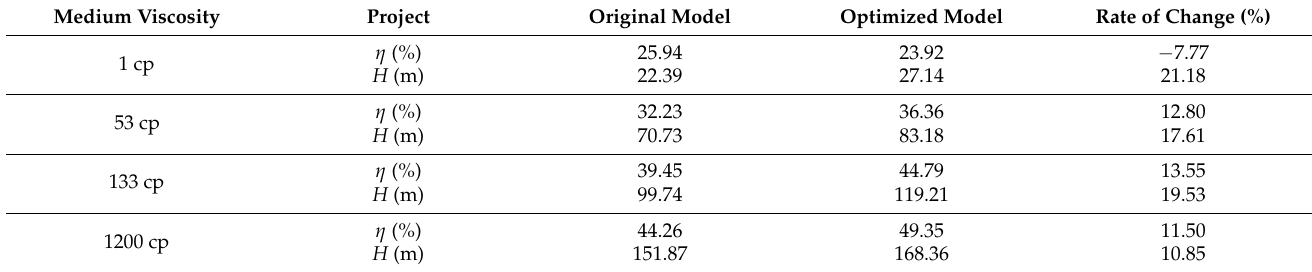
Figure 17. ( a – d ) show the performance comparison between (1) the original model and (2) the optimized model when the viscosity of transporting media is 1 cP, 54 cP, 133 cP and 1200 cP. Table 6. Comparison of target values at the optimal operating point before and after